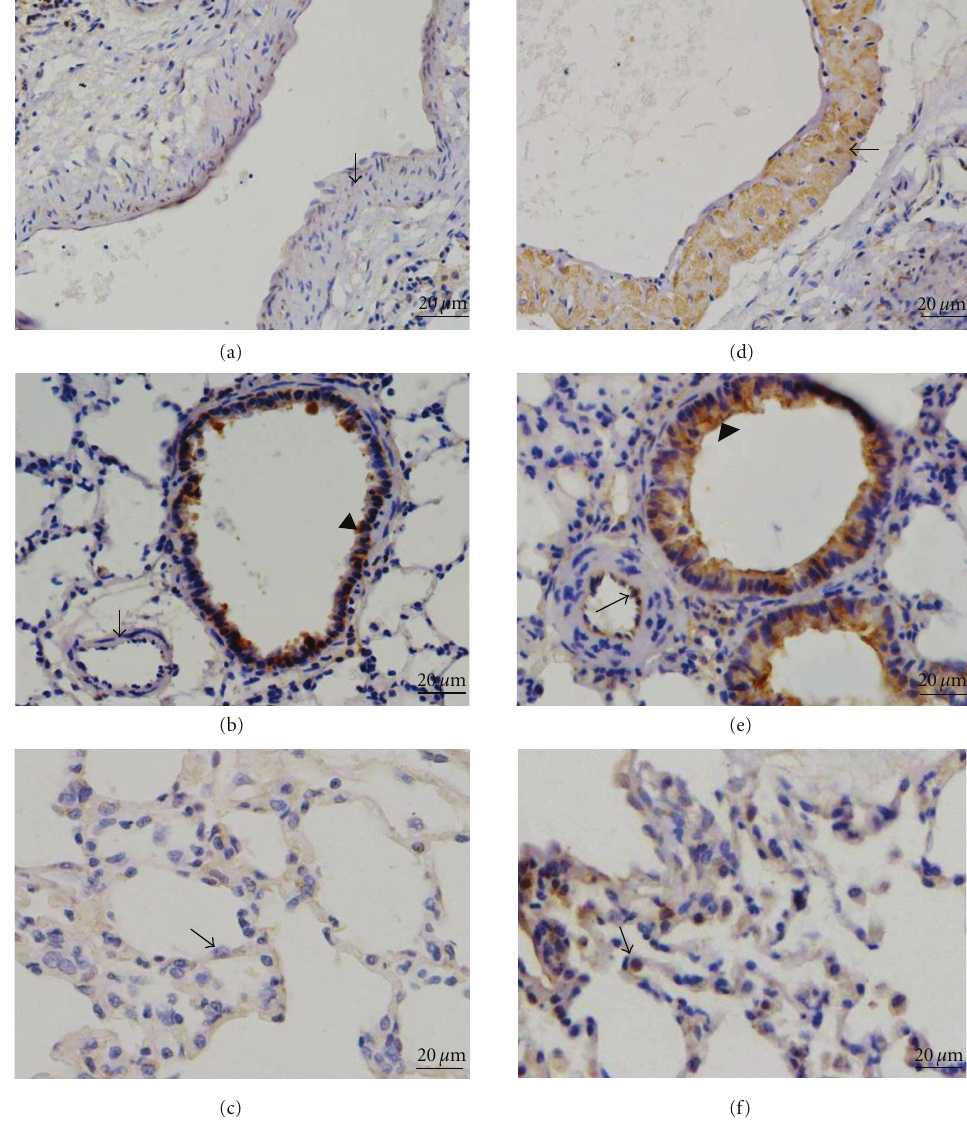
Figure 2: Immunohistochemical analysis of MIF in rat lungs. Immunostaining with an antibody to MIF of normoxic lungs ((a)–(c)) compared with lungs from hypoxic rats ((d)–(f)). The results showed no positive immunoreactivity for MIF in the pulmonary vasculature in control rats (arrow in (a) and (b)), but MIF stained smooth muscle cells of large pulmonary arteries (arrow in (d)), endothelial cells of small pulmonary arteries (arrow in (e)), and inflammatory cells around the alveoli (arrow in (f)) strongly in hypoxic lung sections. Arrows in (c) reveal normal alveoli. Arrowheads in (b) and (e) depict intense staining of bronchial epithelial cells.